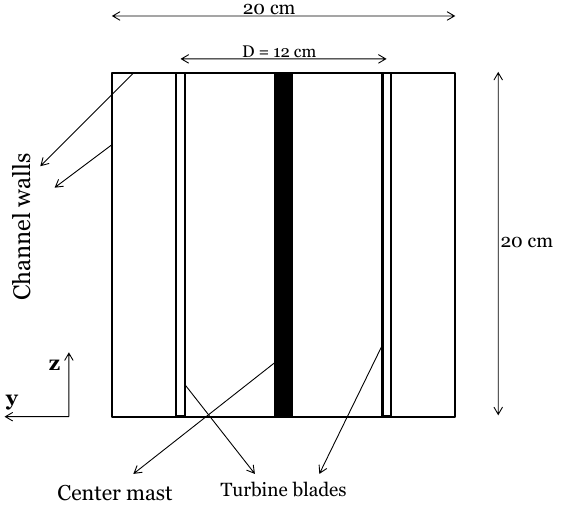
Figure 5. Schematic of y-z view (normal to streamwise direction) of the experimental setup.